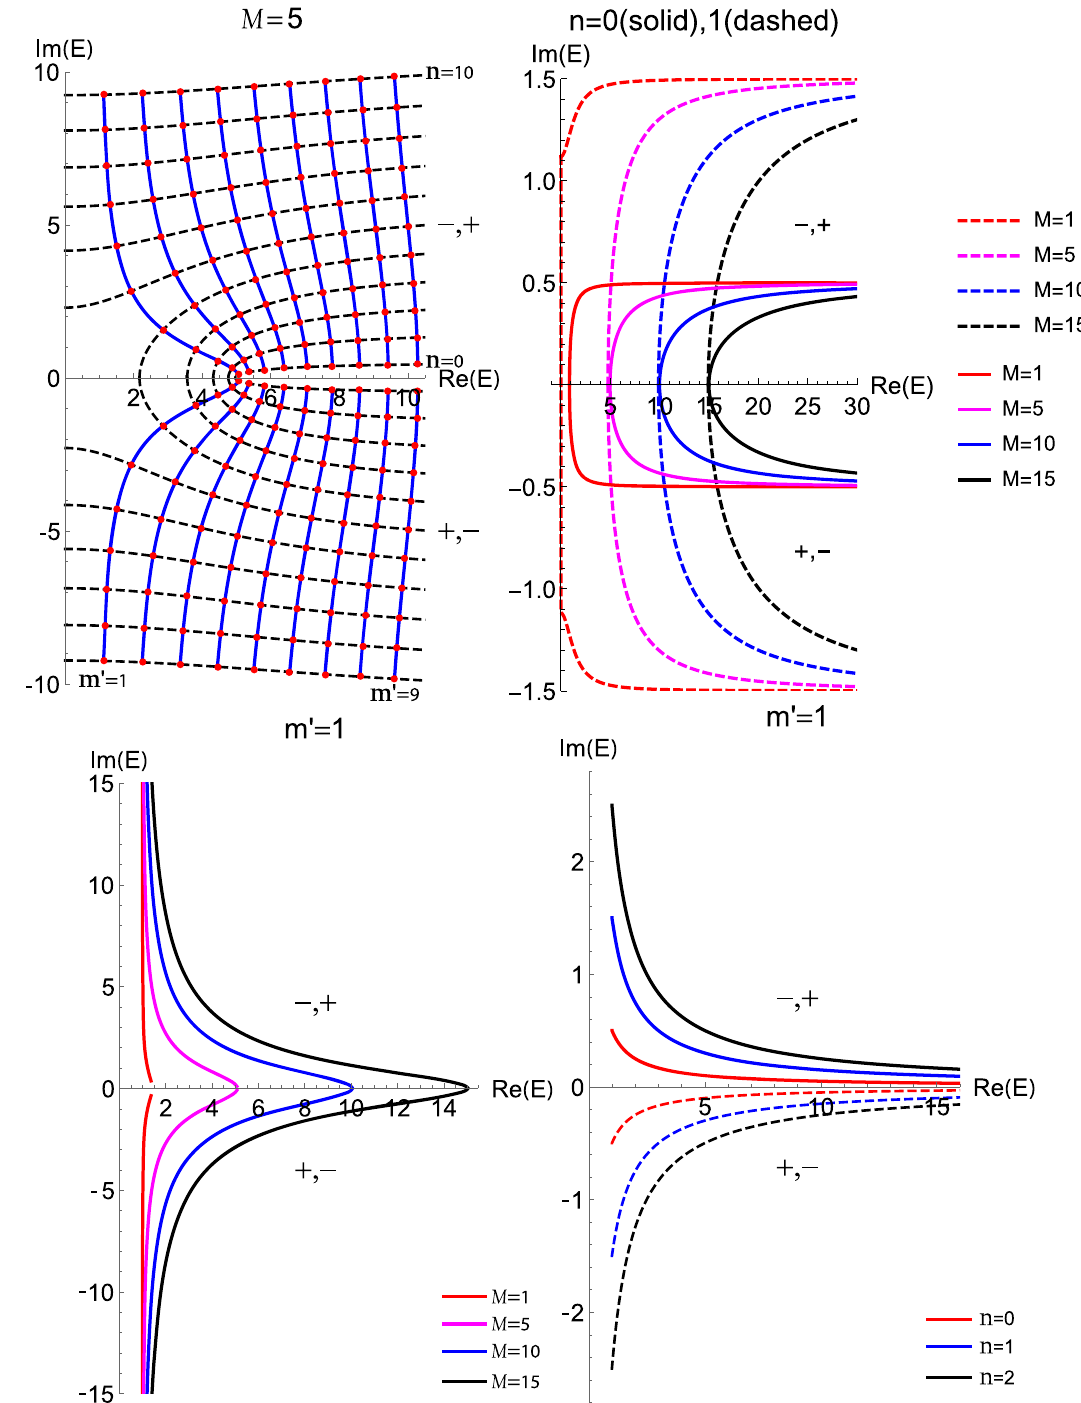
Fig. 6 The QNMs E = ¯ h ω of fermion on the wormhole from Table 1 in natural units for (κ 1 ,κ 2 ) = ( + 1 , − 1 ),( − 1 , + 1